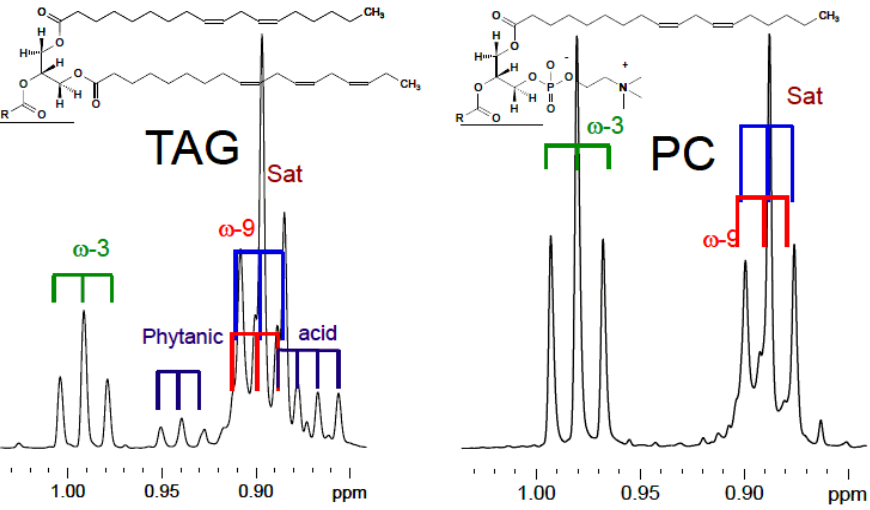
Figure 24. 1 H-NMR spectra of TAG and phospholipids from krill oil after preparative separation. The neutral lipids fraction contains the branched phytanic acid which can also be quantified. Free download from: